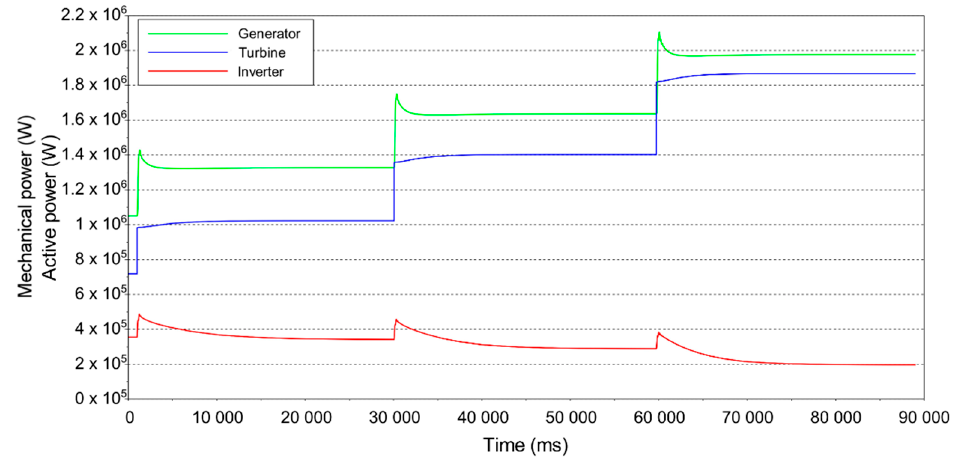
Figure 9. Generated